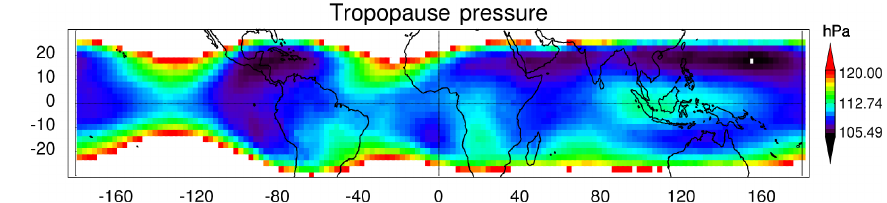
Figure 6. Pressure of the tropopause (hPa) over the tropics during DJF from 2004 to 2017, defined from the NCEP datasets. Table 1. Pearson’s linear correlation coefficient R , regression coefficient α (mgm − 3 mm − 1 h), and the offset β (mgm − 3 ) from the correlation between precipitation and ice water content (IWC), and water vapour (WV) in the upper troposphere (UT, at 146hPa), at day, night, and day − night over the seven tropical zones and the average over the six zones ( µ 6zones